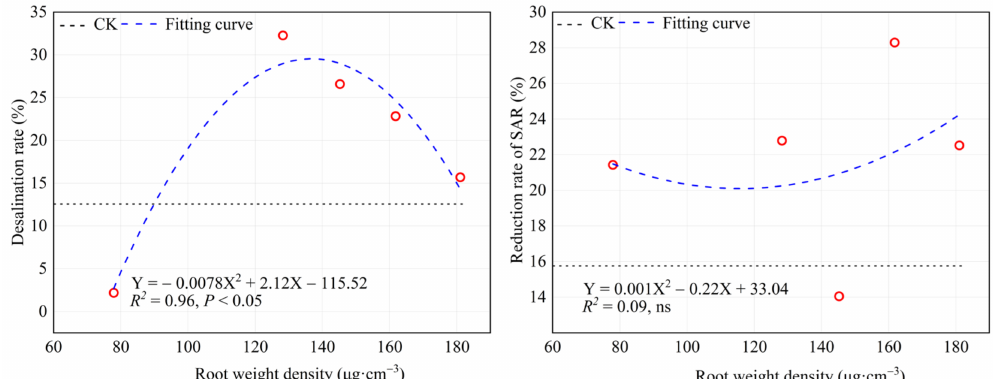
Figure 10. The average soil desalination rate and average SAR reduction rate in relation to okra root weight density. CK represents the value corresponding to bare land. Data are the means of four replicates. SAR refers to sodium adsorption